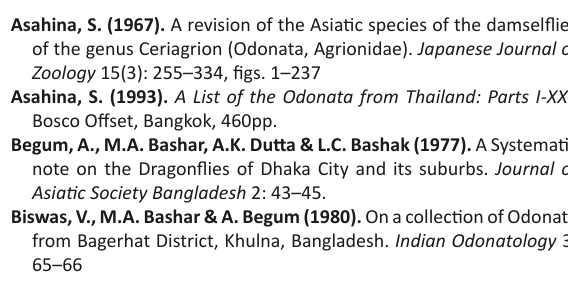
Table 3. A taxonomic summary of odonates of the northeastern region of